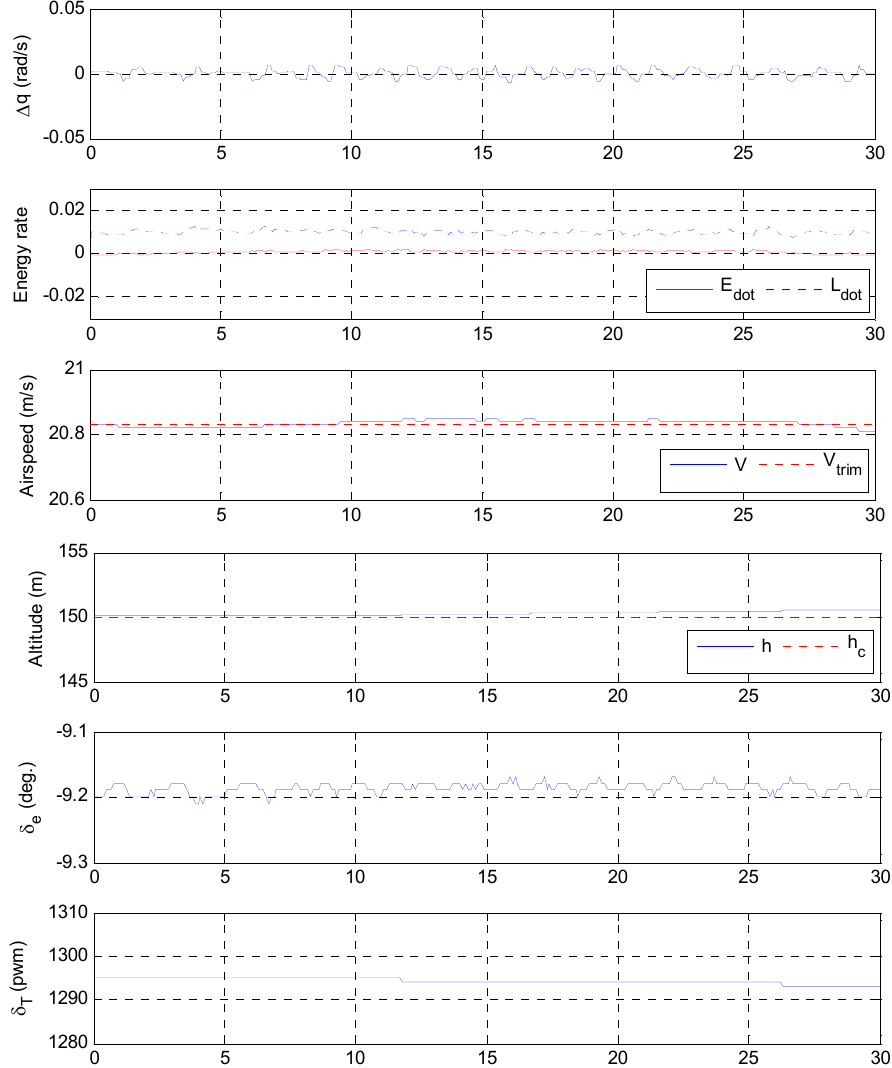
Figure 13. Simulation results of level flight without the presence of wind.